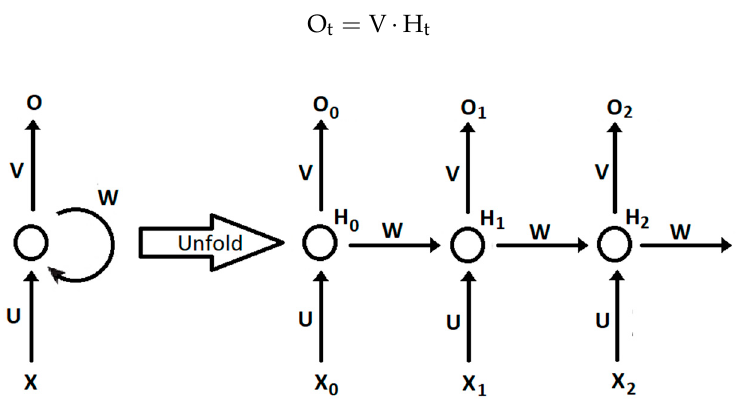
Figure 1. The unfolding of a recurrent neural network.